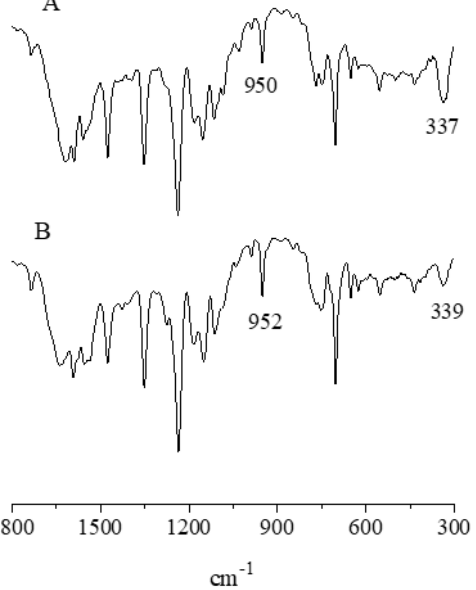
Figure 10. IR spectra in KBr of [(PdCl 2 ) 4 Py 8 TPyzPzIn(OAc)] · 8H 2 O ( A ) and [(PtCl 2 ) 4 Py 8 TPyzPzIn(OAc)] · H 2 O ( B ). The present two hydrated pentanuclear macrocycles [(MCl 2 ) 4 Py 8 TPyzPzIn(OAc)] ˑ xH 2 O (M = Pd II , Pt II ) assigned a structure similar to that